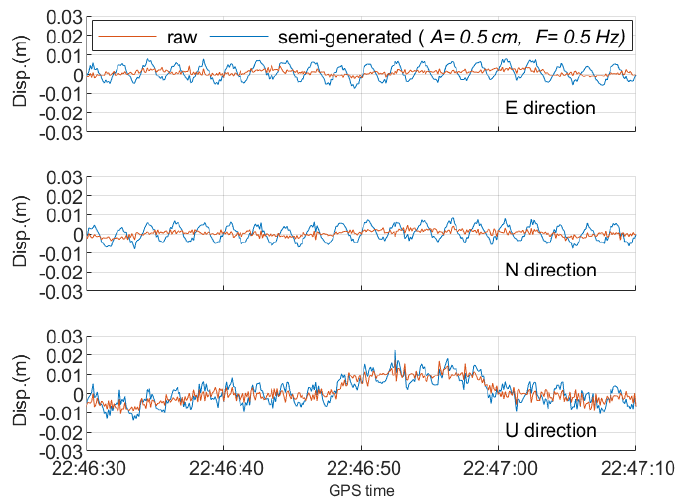
Figure 11. Vibrational displacements with the five-constellation PPP. The red and blue refer to the use of raw and semi-generated GNSS measurements, respectively.